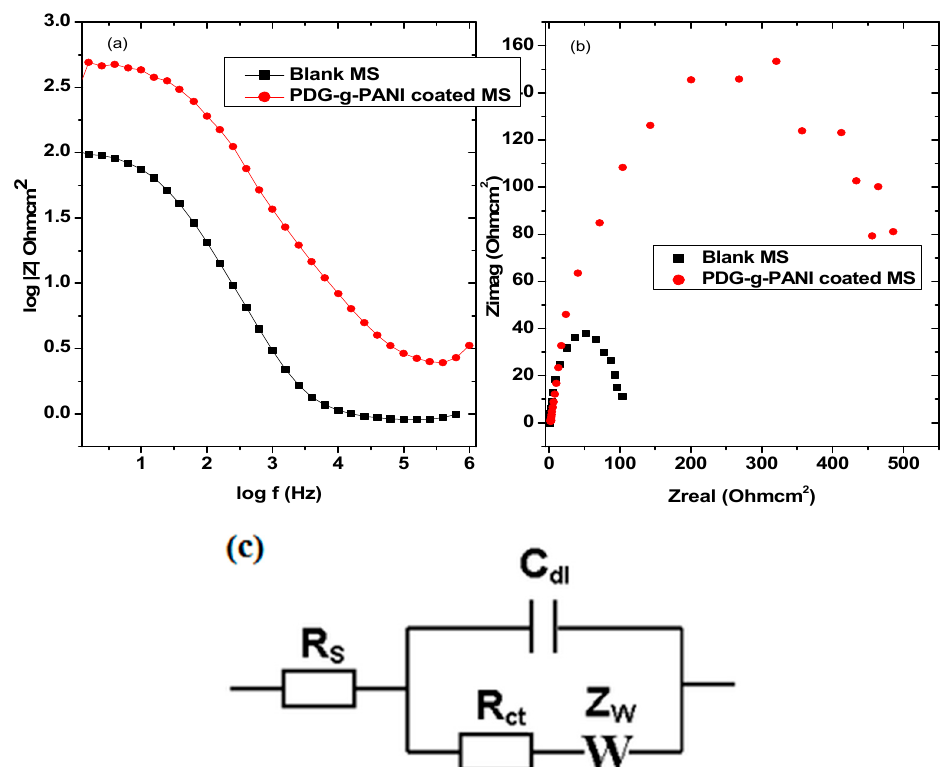
Figure 8. ( a ) Bode and ( b ) Nyquist plots of MS and PDG-g-PANI-coated MS, ( c ) Randles circuit.